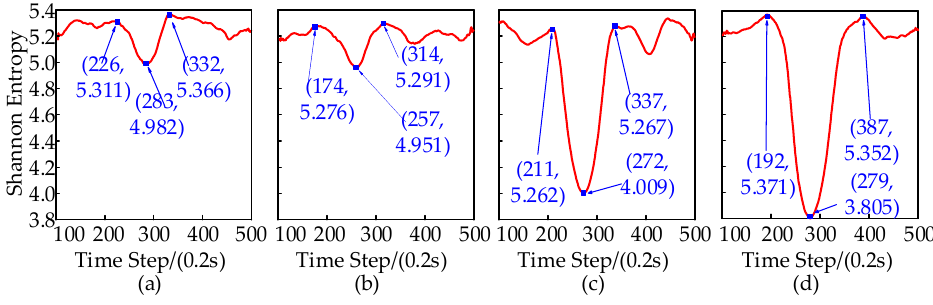
Figure 12. The instantaneous power spectrum entropy curves corresponding to different percentages of thrust loss: ( a ) λ % = 10%; ( b ) λ % = 20%; ( c ) λ % = 30%; ( d ) λ % = 40%. As shown in Figure 12a, the minimum of the entropy curve corresponding to the percentage of thrust loss of 10% is 4.982 at time step 283. Its adjacent maximum on the left is 5.311 at time step 226, and the one on the right is 5.366 at time step 332. Therefore, the distortion interval of the entropy curve is [226 332]. The time boundaries of the local region are [226 332]. Similarly, the time boundaries are [174 314], [211 337], and [192 387], corresponding to percentages of thrust loss of 20%, 30%, and 40%, respectively. The time boundaries of the local region are set in Figure 13.